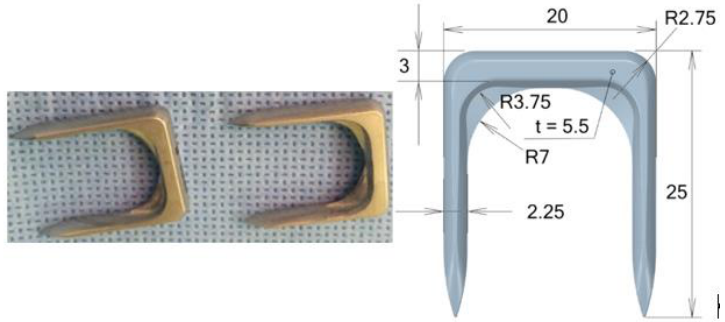
Figure 5. Physical model and 3D CAD model with main dimensions (mm), supplied by MEDIN, a.s.